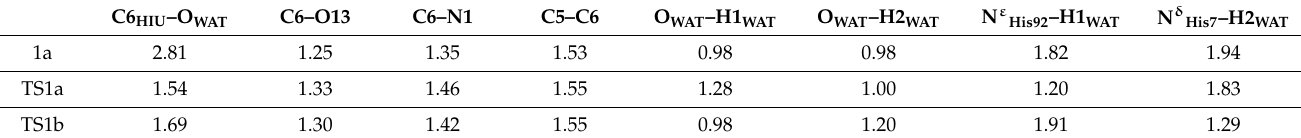
Table 3. Some important bond lengths (Å) related to reaction coordinate in la , TS1a and TS1b .